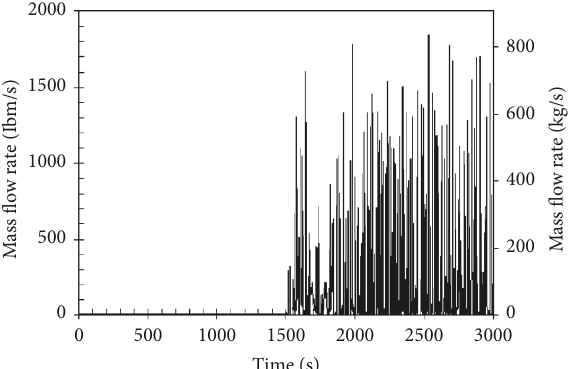
Figure 29: 10-inch Cold Leg Break: ADS-4 (NOTRUMP code) [7].